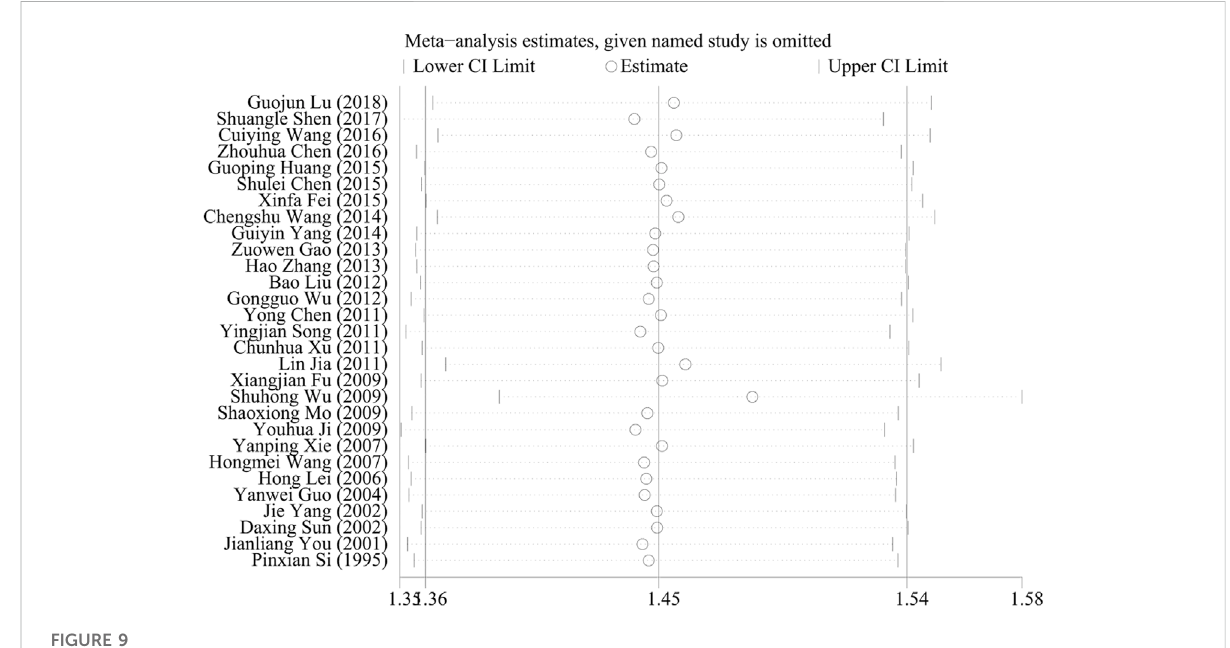
FIGURE 9 Sensitivity analysis diagram of total effective rate.